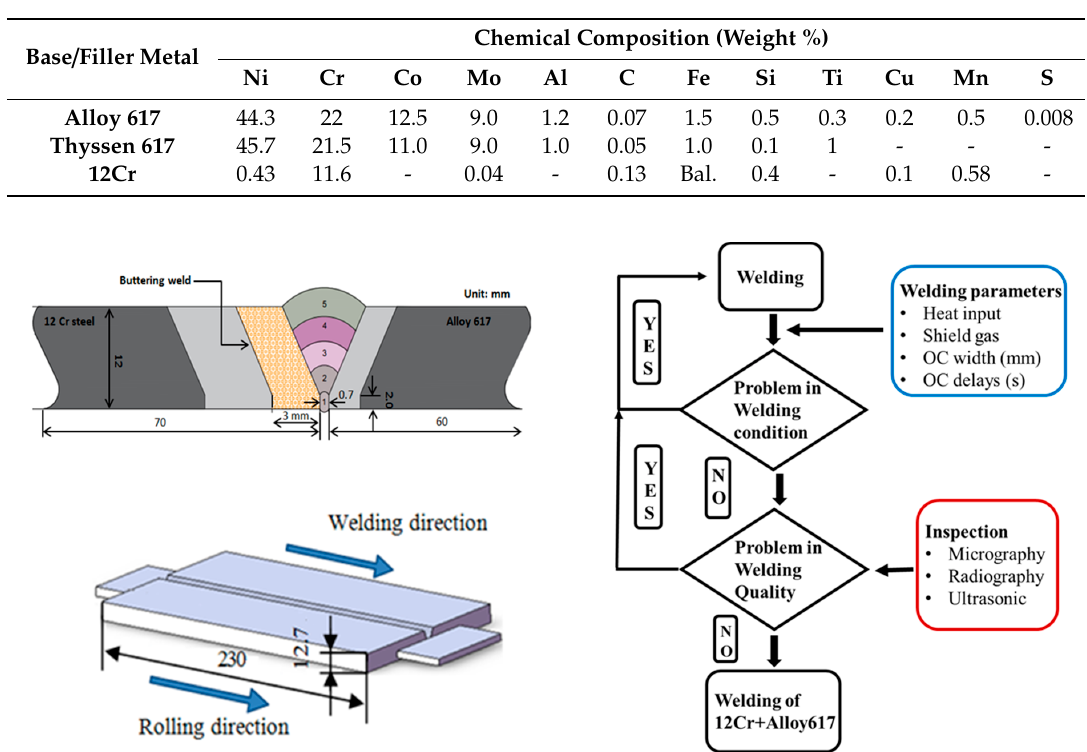
Table 1. Chemical composition of Alloy 617, Thyssen 617 and 12 Cr steel. Data from [11].